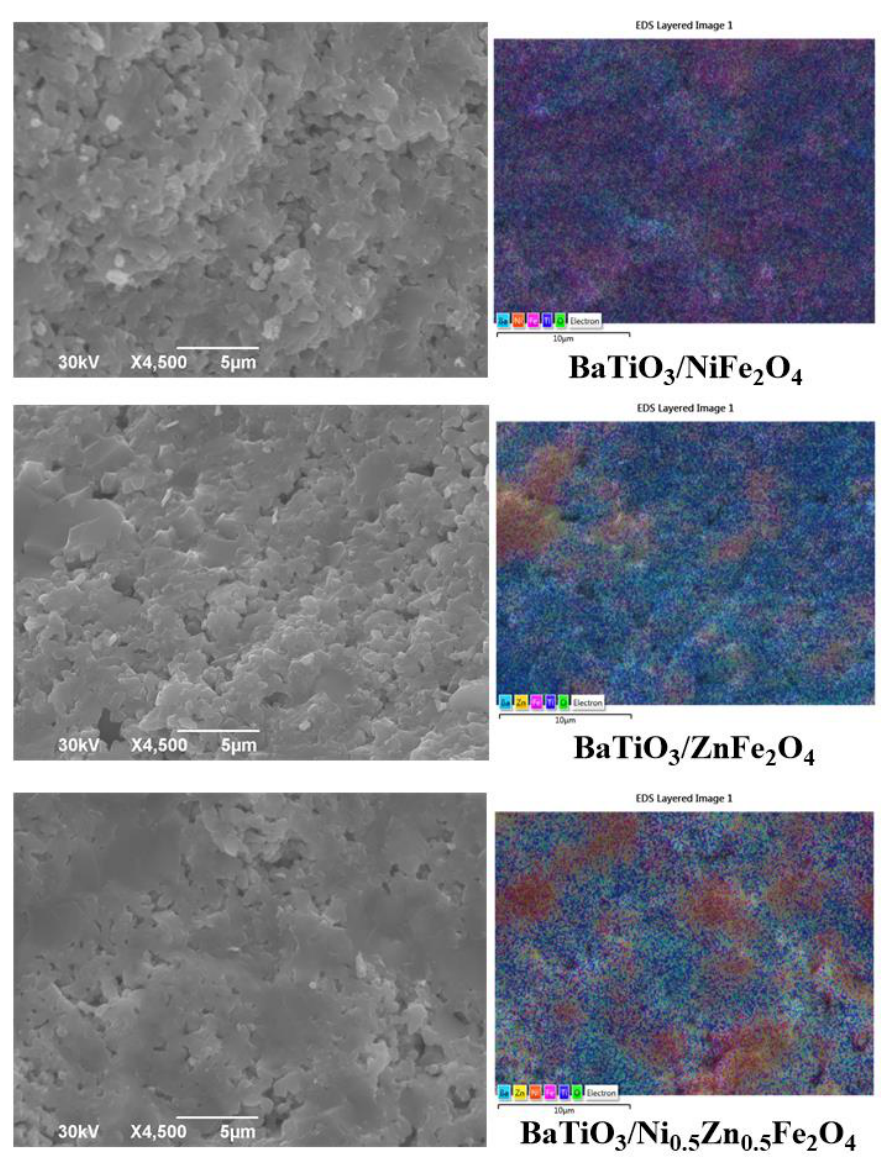
Figure 4. SEM and EDS layered images of BaTiO 3 /NiFe 2 O 4 , BaTiO 3 /ZnFe 2 O 4 , and SEM and EDS layered images of BaTiO 3 /NiFe 2 O 4 , BaTiO 3 /ZnFe 2 O 4 , and BaTiO 3 /Ni 0.5 Zn 0.5 Fe 2 O 4 samples sintered at 1300 °C (Ba-cyan; Zn-yellow; Ni-orange; Fe-magenta; Ti- BaTiO 3 /Ni 0.5 Zn 0.5 Fe 2 O 4 samples sintered at 1300 ◦ C (Ba-cyan; Zn-yellow; Ni-orange; Fe-magenta; blue; O-green). Ti-blue;